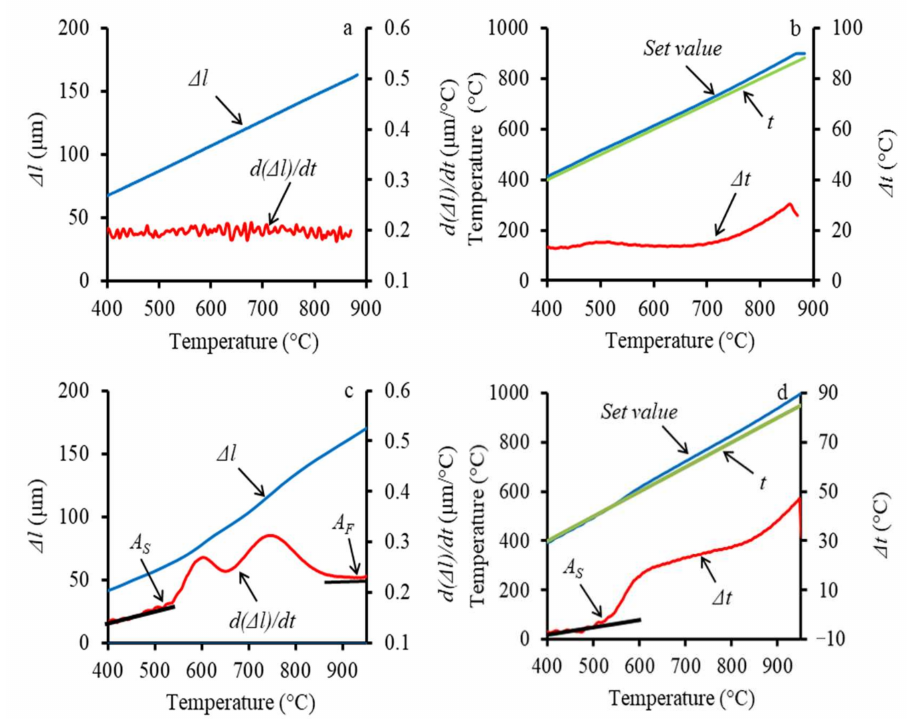
Figure 3. The results of dilatometric measurements at a heating rate of 400 ◦ C/s of the as-received ( a , b ) and as-processed program steel ( c , d ): ( a , c )—dilatogram ( ∆ l) and the first derivative (d( ∆ l)/dt); ( b , d )—set value of temperature (Set value), the real temperature of a specimen (t), the difference between the set value of temperature and real temperature of a specimen ( ∆